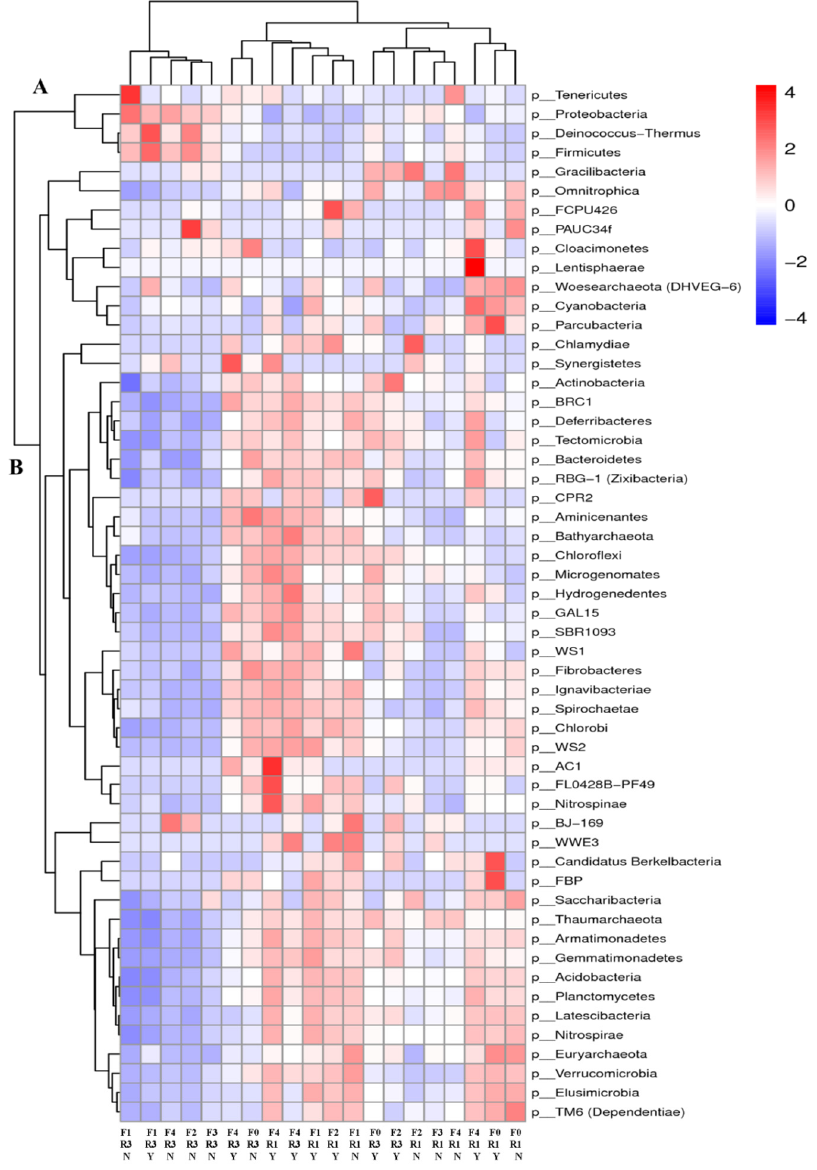
Figure 2. The phylum horizontal species composition of the declutter heat map for rhizosphere soil of different fertilization treatments. A heat map showing the top 54 bacterial OTUs for soils of different treatments. Y: Yangzhou; N: Nantong; R1: silking stage; R3: milking stage; F0: no fertilizer; F1, F2, and F3 represent new compound fertilizer applied 225 kg N ha − 1 at sowing, V3, and V6 stages, respectively; F4: applied 75 kg N ha − 1 traditional compound fertilizer at sowing stage and 150 kg N ha − 1 urea at V6 stage. Analysis software: R script, heat map package.